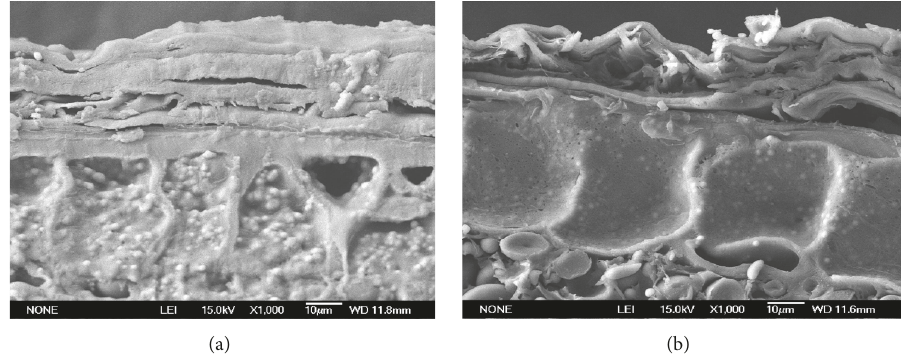
Figure 2: SEM of green and normal wheat brans. (a) GW3104 and (b) YN19.